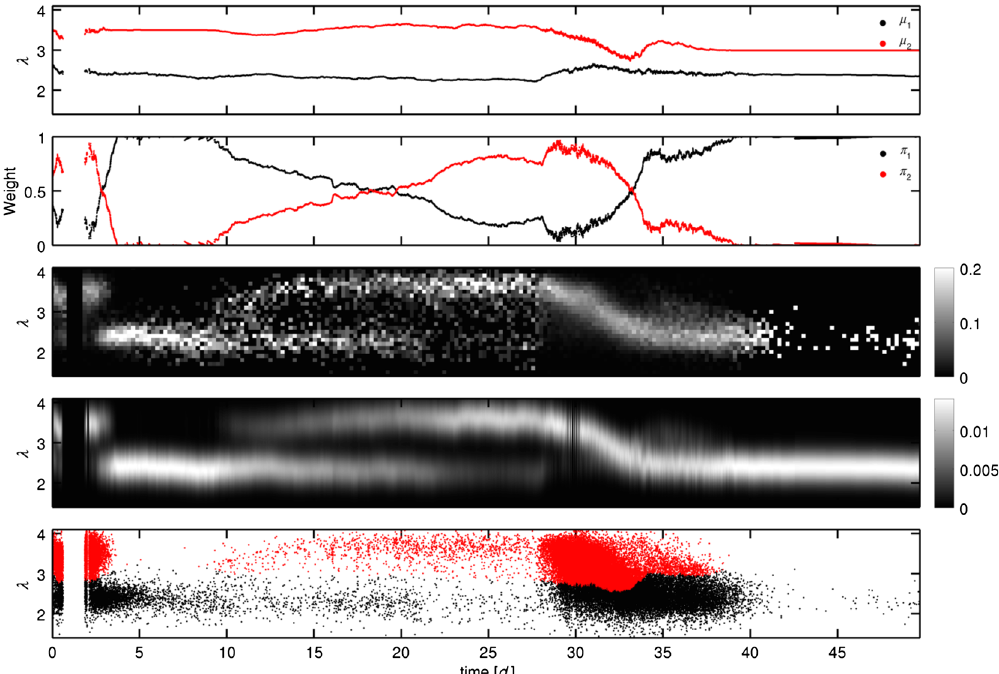
FIG. 11. Gaussian mixture model fit for one replicate in the I ¼ 0 . 25 I 0 condition. The upper panel shows the means of the two modes ( μ 1 and μ 2 ), the second panel shows the weights of these modes in the mixture distribution ( π 1 and π 2 , respectively), the third panel shows a histogram of the raw data, and the fourth panel shows the inferred probability density at each time point. In both the third and fourth panels, each column (time point) is normalized independently. The bottom panel plots the classification with large cells in red and small cells in black; note that there is no overlap between these